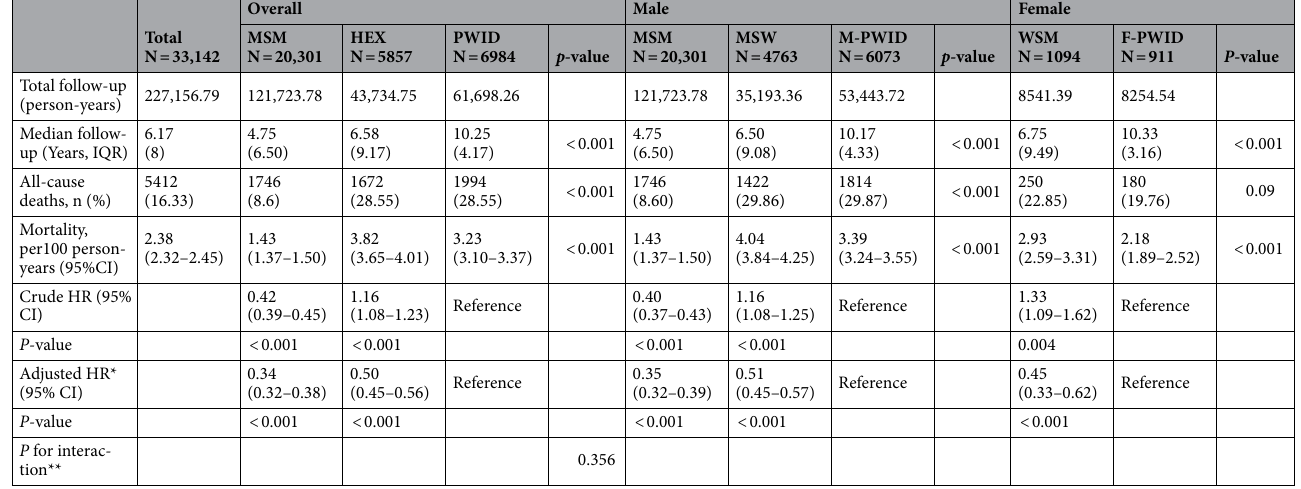
Table 2. Association of transmission categories with all-cause mortality, overall and within each sex. Abbreviation: AIDS, acquired immunodeficiency syndrome; CI, confidence interval; HEX, heterosexual; HIV, human immunodeficiency virus; PWID, persons who inject drugs; PWID-M, male injection drug use; PWID-W, female injection drug use; IQR, interquartile range; MSM, man who have sex with man; MSW, man who has sex with woman; WSM, woman who has sex with man. *Adjusted hazard ratio (HR) with 95% CI was estimated after adjustment for age group, sex, period of HIV diagnosis, HIV transmission category, marital status, occupation, specimen source, HIV diagnosis region, and AIDS event in all set; and age group, period of HIV diagnosis, HIV transmission category, marital status, occupation, specimen source, HIV diagnosis region, and AIDS event in sex-stratified analyses. **We found no significant interaction between sex and HIV-related risk on the all-cause